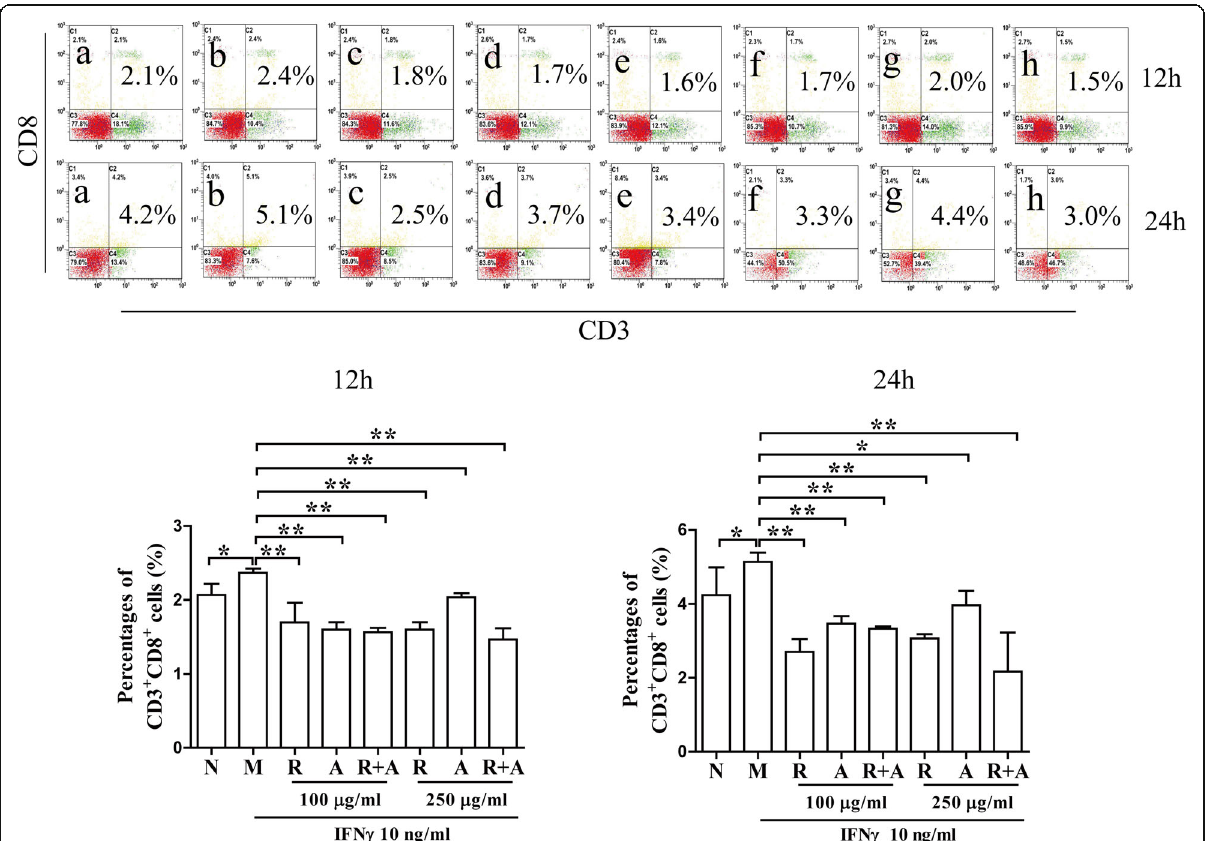
Fig. 4 Effects on the proliferation of CD3 + CD8 + T cells in BM cells after 12 and 24 h of treatment. The results are presented in bar charts. a, Normal (N) group; b, Model (M) group; c and f, Radix Astragali (R) group; d and g, Radix Angelicae Sinensis (A) group; e and h, Radix Astragali + Radix Angelicae Sinensis (R + A) group; c, d and e were treated with 100 μ g/mL of freeze-dried powders, and f, g and h were treated with 250 μ g/ mL of freeze-dried powders. The results are presented in a bar chart. Data are presented as the mean ± SD, n = 3. * P < 0.05 and ** P <